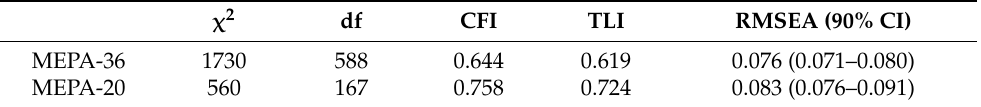
Table 4. Model Fit